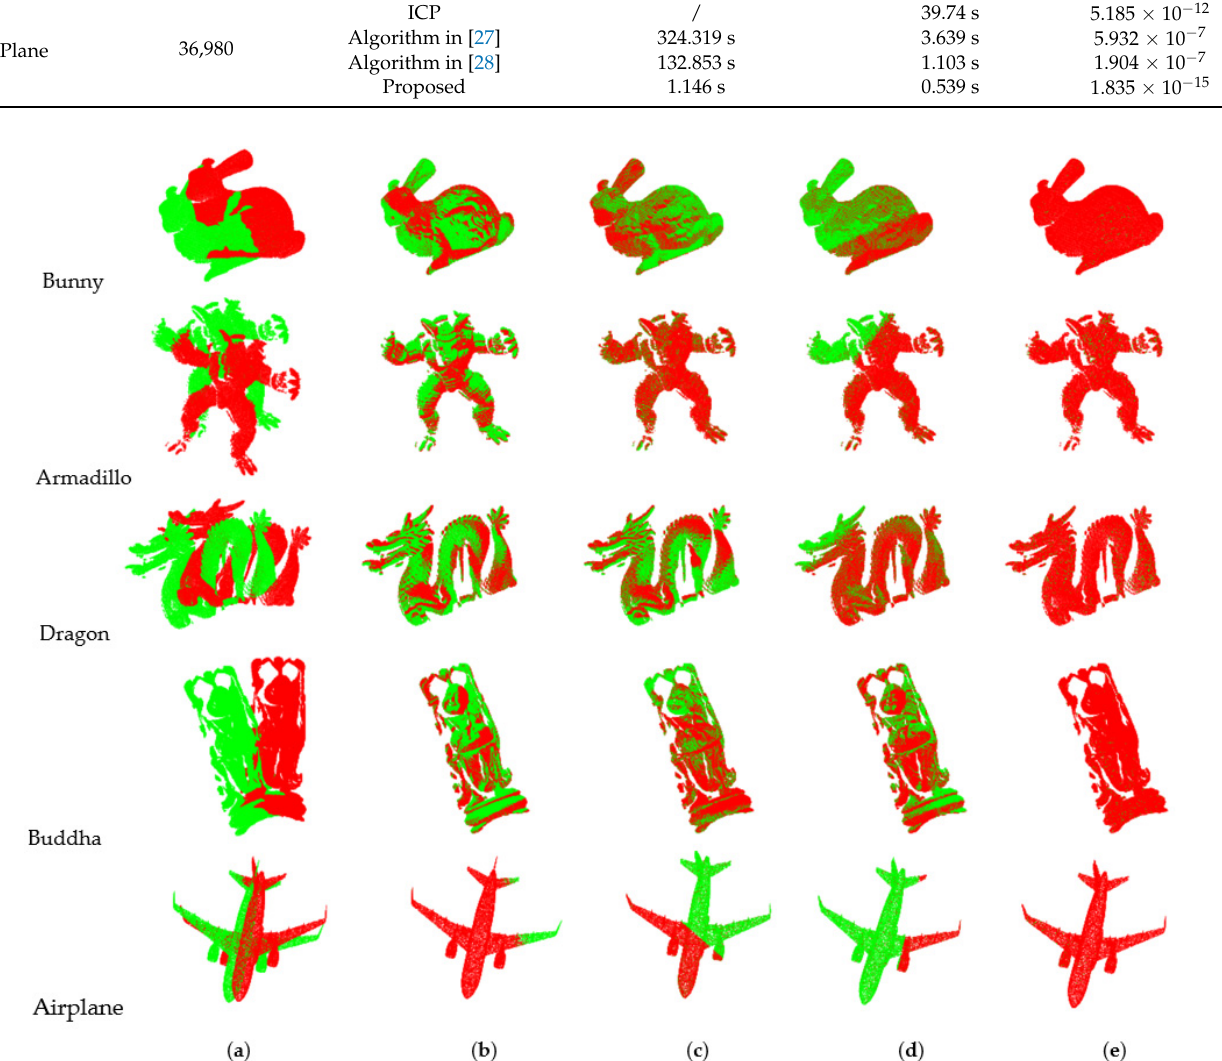
Figure 6. Registration effect of the same angle. ( a ) Initial position; ( b ) ICP; ( c ) Algorithm in [27]; ( d